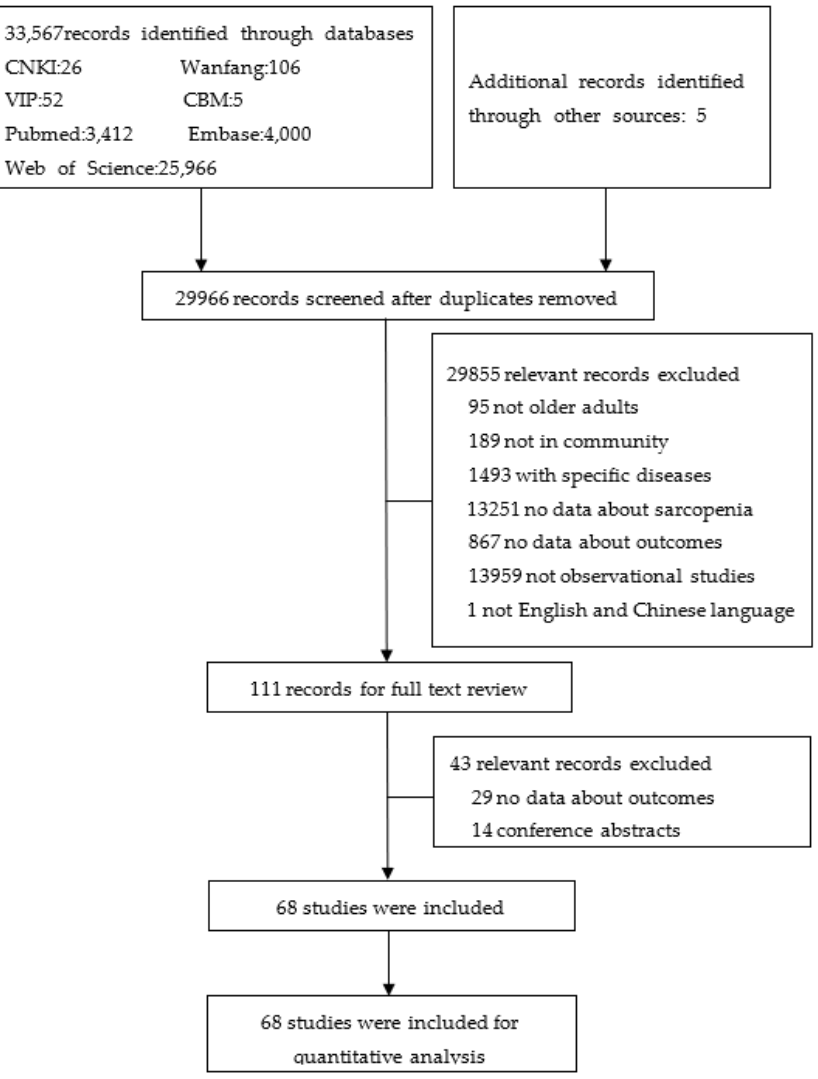
Figure 1. PRISMA flowchart.